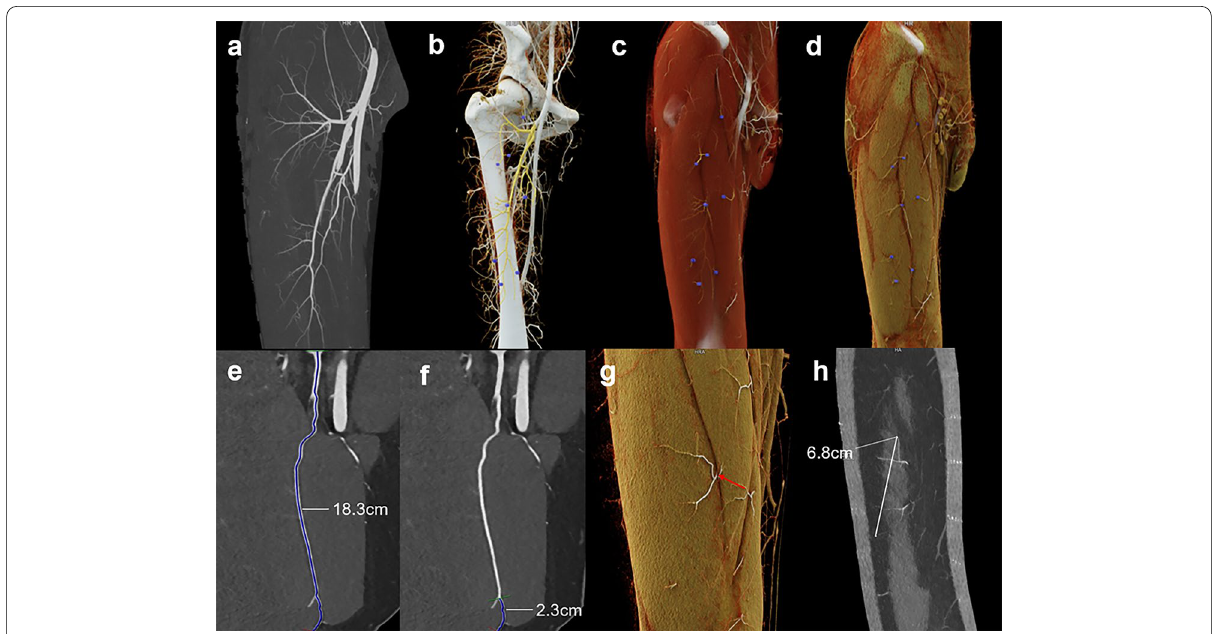
Fig. 4 Description of anatomical characteristics and parameter measurement of ALTPs. a–d Maximum intensity projection image ( a ) and cinematic rendering images ( b–d ) represented by a three‑tier organization structure (from deep blood vessel to subcutaneous tissue). A solitary origin of the descending branch directly from the deep femoral artery was identified. A total of eight perforators (five septocutaneous perforators and three musculocutaneous perforators) were found; two perforators originated from the ascending branch and the remaining six perforators from the descending branch. The emerging point of perforators through deep fascia was marked in cinematic rendering images. e–h Measurement of maximum length (18.3 cm) of perforator from the origin of descending branch to the emerging point at deep fascia ( e ) and minimum length (2.3 cm) of perforator ( f ). The emerging point of a perforator containing two main sub‑branches in distal was marked by a red arrow ( g ), and the diameter of a skin flap nourished by this perforator was 6.8 cm ( h